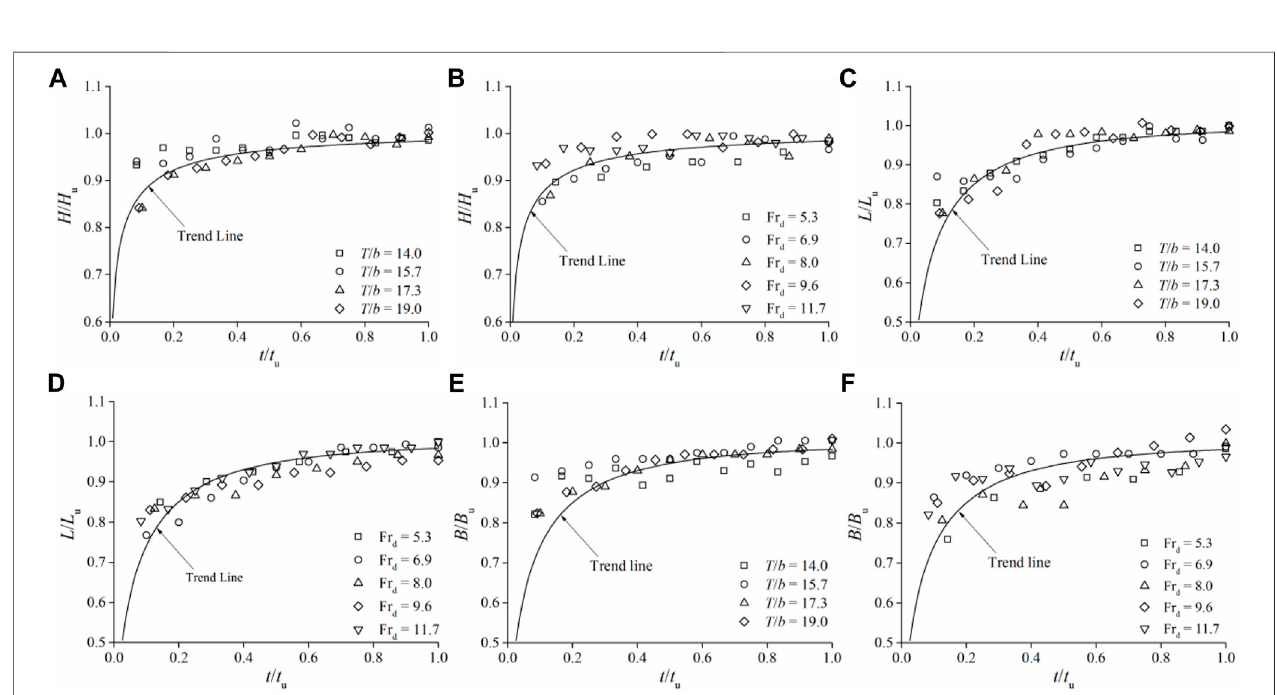
FIGURE 5 | Effects of jet impingement on the time-domain scour process. (A) H/H u ( t/t u ), (B) H/H u ( t/t u ), (C) L/L u ( t/t u ), (D) L/L u ( t/t u ), (E) B/B u ( t/t u ) and (F) B/B u ( t/t u ) with ( — ) is trend line.